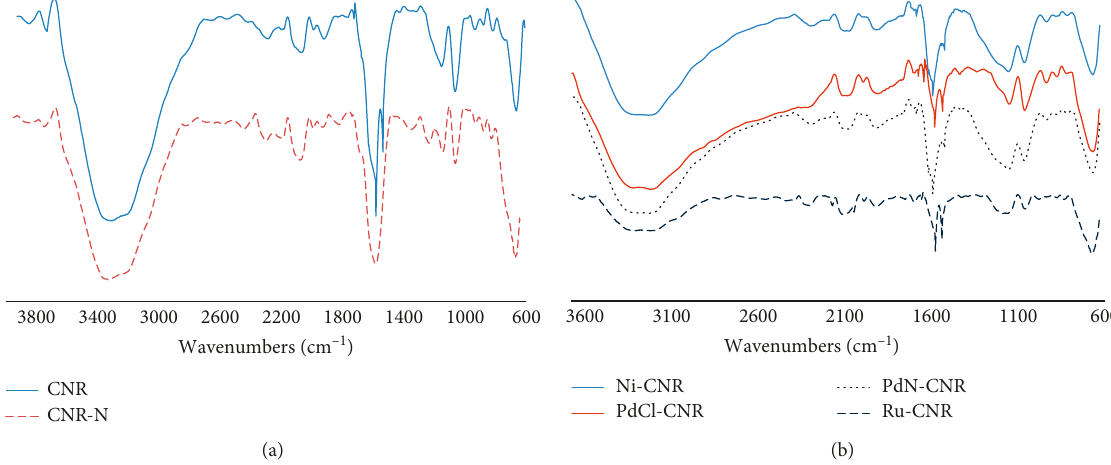
Figure 2: FTIR micro-ART spectra for the supports (a) CNR and CNR-N and for the catalysts (b) PdCl/C, PdN/C, NiCl/C, and RuCl/C.